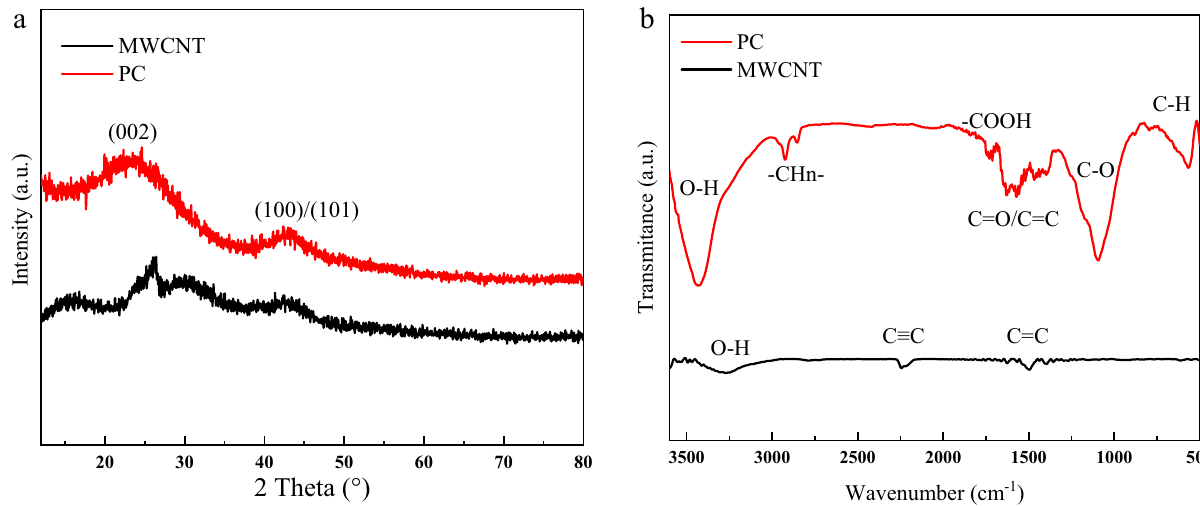
Figure 3. XRD patterns ( a ) and FTIR spectra ( b ) of the prepared porous carbon and